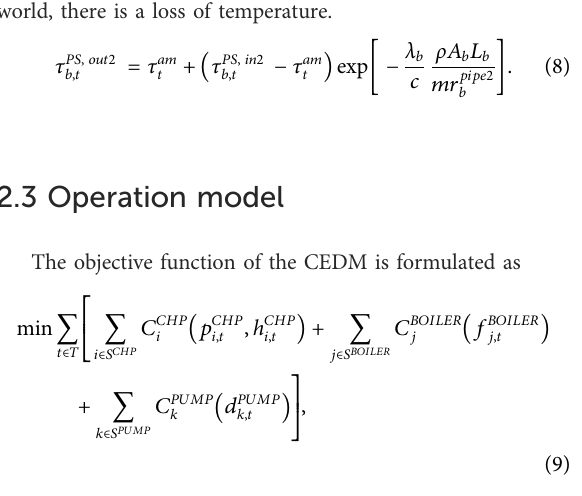
FIGURE 2 Typical structure of